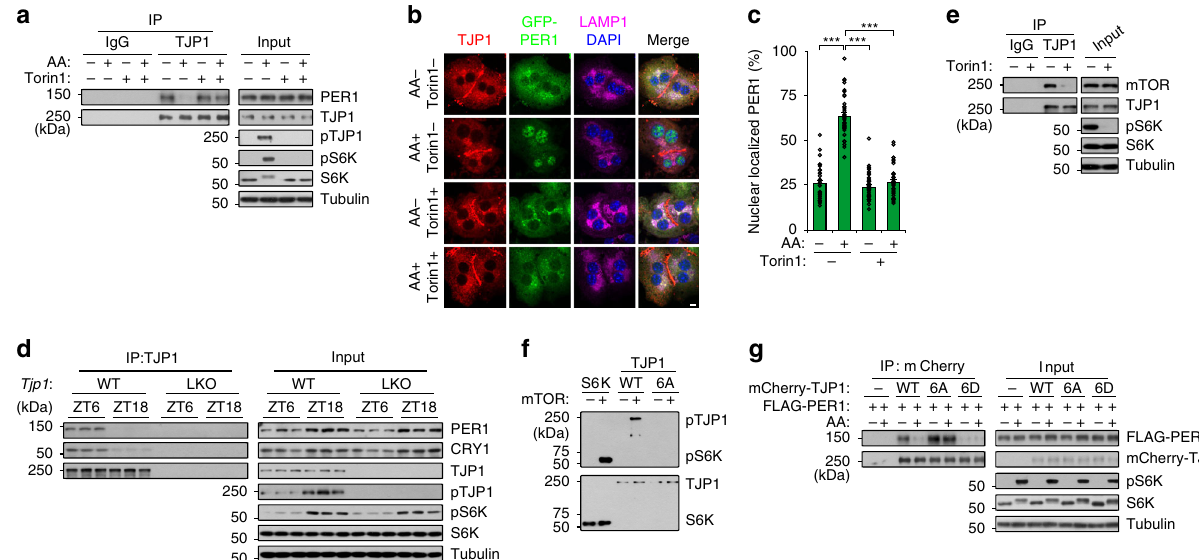
Fig. 2 mTOR attenuates the association of TJP1 and PER1. a Co-immunoprecipitation (co-IP) showing the interaction of endogenous TJP1 and PER1 in primary hepatocytes cultured in a collagen sandwich con fi guration in response to treatment with amino acids and/or Torin1. Mouse primary hepatocytes incubated with amino acid-free RPMI1640 for 6 h were exposed to 250nM Torin1 or control vehicle for another 30 min, then treated with amino acids for 30 min. b and c Cellular localization of GFP-PER1 and endogenous TJP1 b and statistical analysis of the results c in primary hepatocytes cultured in a collagen sandwich con fi guration in response to treatment with amino acids and/or Torin1. Mouse primary hepatocytes incubated with amino acid-free RPMI1640 for 6 h were exposed to 250 nM Torin1 or control vehicle for another 30 min, then treated with amino acids for 30 min. Scale bar, 10 μ m. Data are shown as mean ± s.e.m. Comparison of different groups was carried out using two-way ANOVA. ***P < 0.001, n = 6. d Immunoblots of co-IP assays showing the interaction of endogenous TJP1 and PER1 in liver extracts harvested from mice at ZT6 and ZT18. e Co-IP assay showing the interaction of endogenous mTOR and TJP1 in primary hepatocytes cultured in a collagen sandwich con fi guration. Mouse primary hepatocytes were exposed to 250 nM Torin1 or control vehicle for 1 h. f In vitro kinase assay showing the phosphorylation of HA-tagged TJP1 and S6K by truncated mTOR. HA-tagged TJP1 and S6K were puri fi ed from mouse Mtor LKO primary hepatocytes infected with adenovirus expressing HA-tagged S6K or wildtype TJP1 or mutant TJP1 (6A). g Immunoblots of co-IP assays showing the interaction of FLAG-PER1 and mCherry-tagged TJP1 or its mutants in mouse primary hepatocytes in the presence or absence of amino acids. 6A is the T589A/T709A/S927A/S1360A/S1460A/S1617A mutant of human TJP1, while 6D is the T589D/T709D/ S927D/S1360D/S1460D/S1617D mutant of human TJP1. pTJP1 indicates human TJP1 phosphorylated at S1617 or mouse TJP1 phosphorylated at S1614. Source data are provided as a Source Data fi